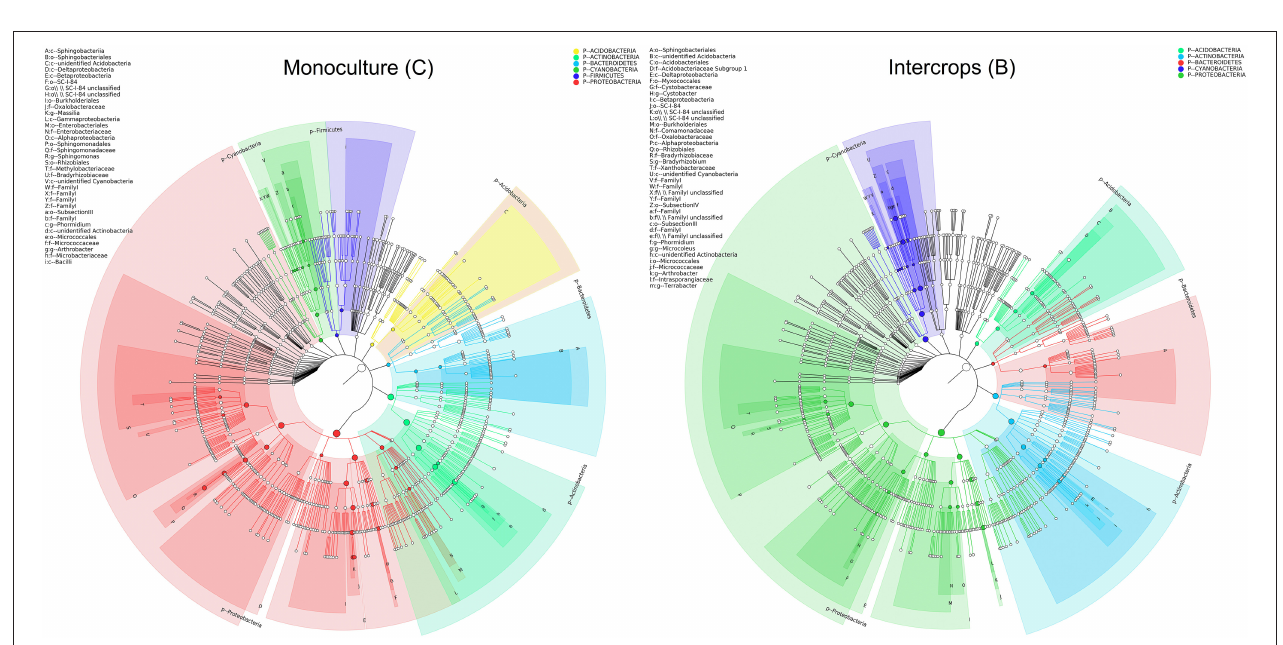
FIGURE 5 | Species annotation of ITS groups presented in conjunction with the GRAPhlAn. The circles in the figure represent different classification levels from the inside out, the different colors represent different phylum, and the top 40 species in abundance are represented by solid circles. B: Intercrop, C: Monoculture.